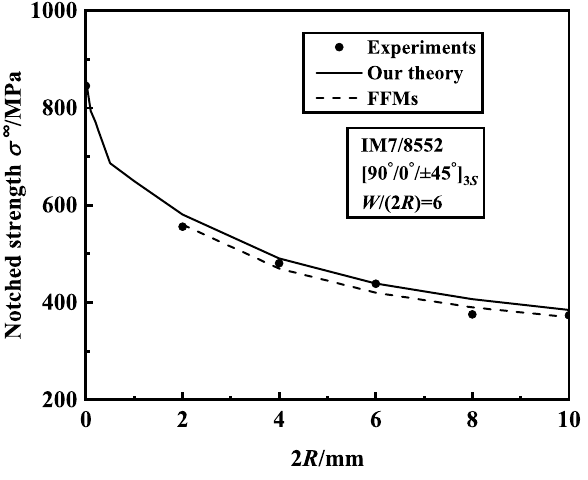
Figure 2. The uniaxial tensile strength of [ 90 ◦ /0 ◦ / ± 45 ◦ ] hole